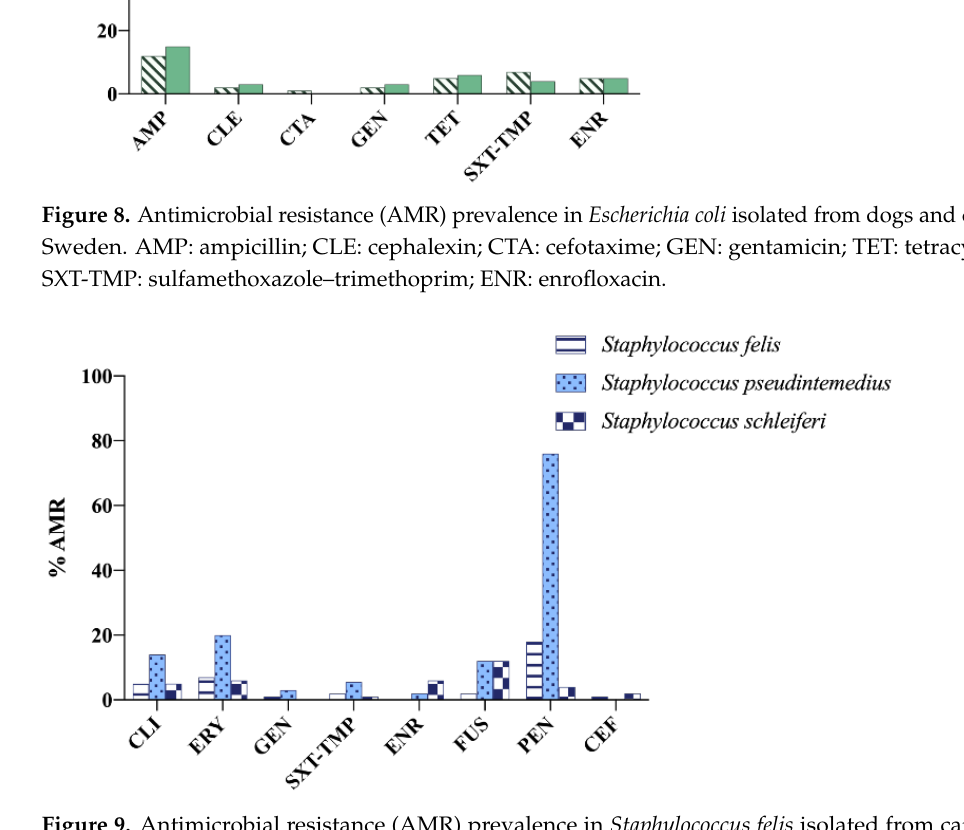
Figure 9. Antimicrobial resistance (AMR) prevalence in Staphylococcus felis isolated from cats and Staphylococcus pseudintermedius and Staphylococcus schleiferi isolated from dogs in Sweden. CLI: clindamycin; ERY: erythromycin; GEN: gentamicin; SXT-TMP: sulfamethoxazole – trimethoprim; ENR: enrofloxacin; FUS: fusidic acid; PEN: penicillin; CEF: cephalothin.